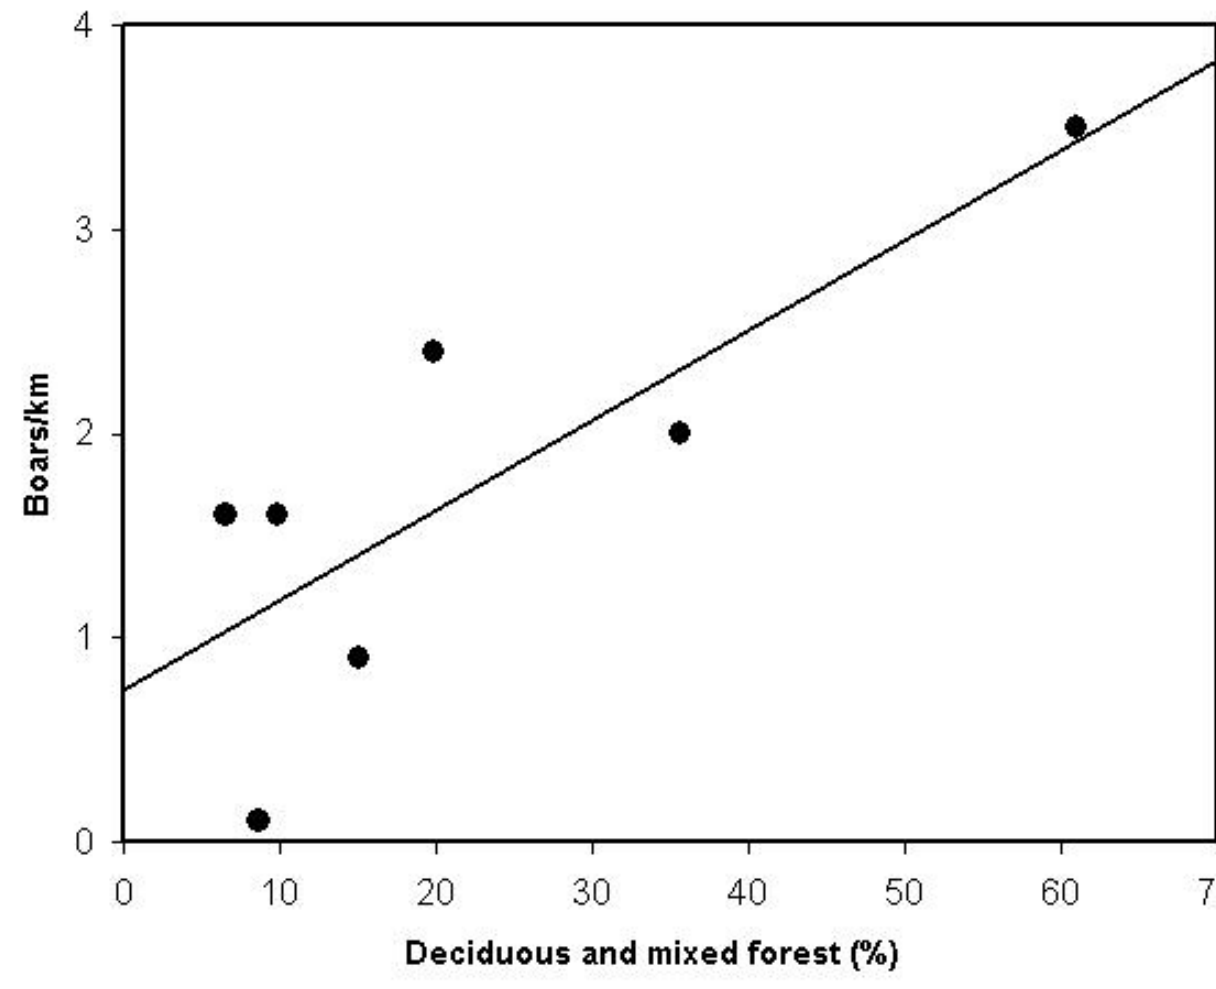
Fig. 1 . The relationship between boar density and forest composition found for seven forests in Poland exploited for commercial use (modified after Jedrzejewska et al.